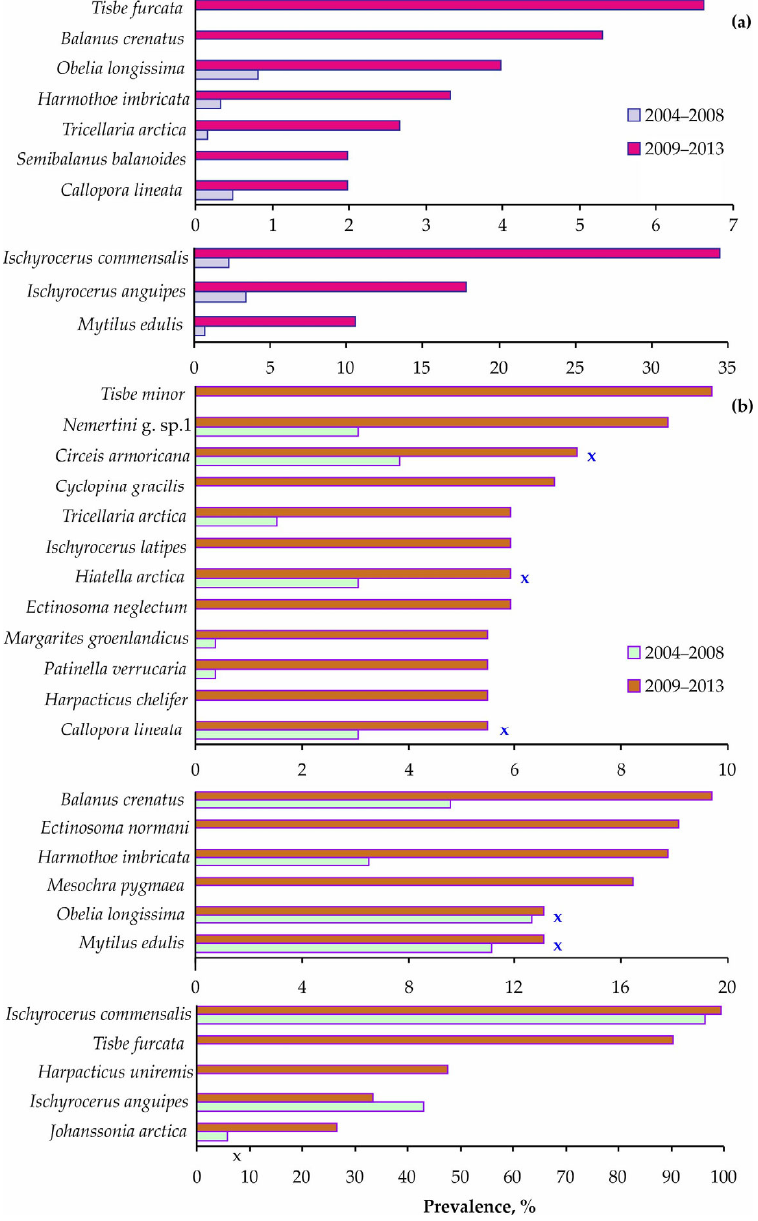
Figure 7. Total infestation prevalence on red king crabs from Dalnezelenetskaya Bay in summers during the 2004–2008 [32] and 2009–2013 periods. ( a ) Immature crabs, ( b ) mature crabs. X indicates insignificant differences (Chi ‐ squared test, p > 0.05).